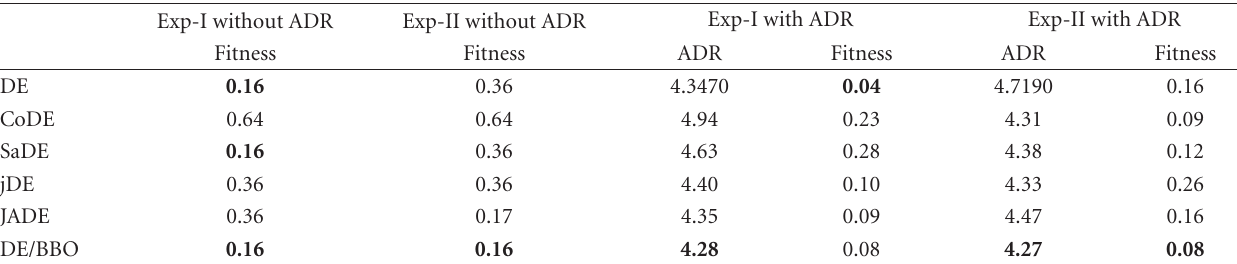
Table 7: Comparison of DE/BBO with DE, CoDE, SaDE, jDE, JADE.